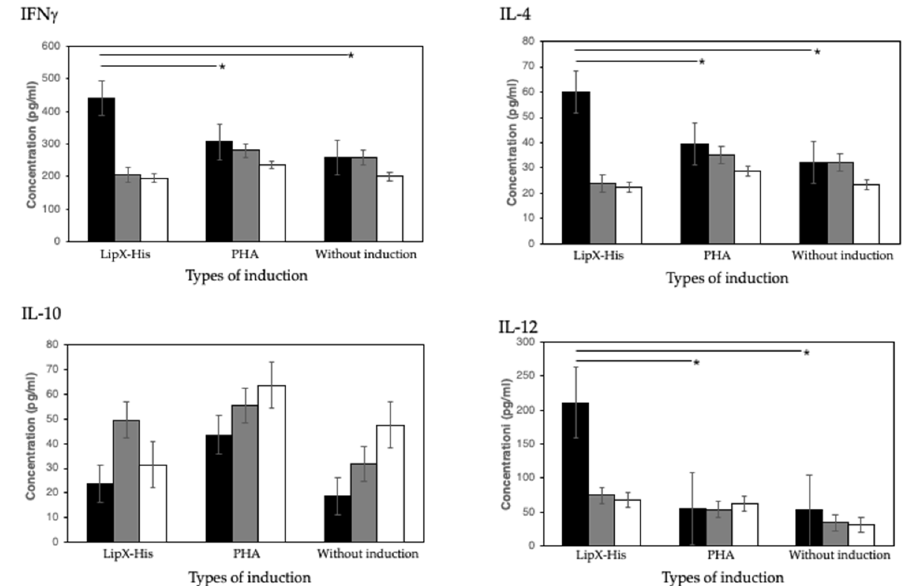
Figure 3. Concentration of IFN- γ , IL-4, IL-10, and IL-12 between immunization groups following the stimulation of splenocytes with LipX-His or PHA, as well as without induction. Black, splenocytes from mice immunized with pcDNA3.1- lipX. Gray, splenocytes from mice immunized with pcDNA3.1. White, splenocytes from mice without immunization. Asterix label (*) indicates a statistically significant difference